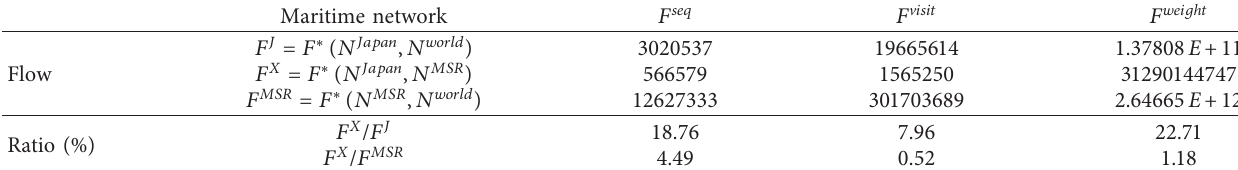
Table 11: Ratios of flows between Japan and the Maritime Silk Road.